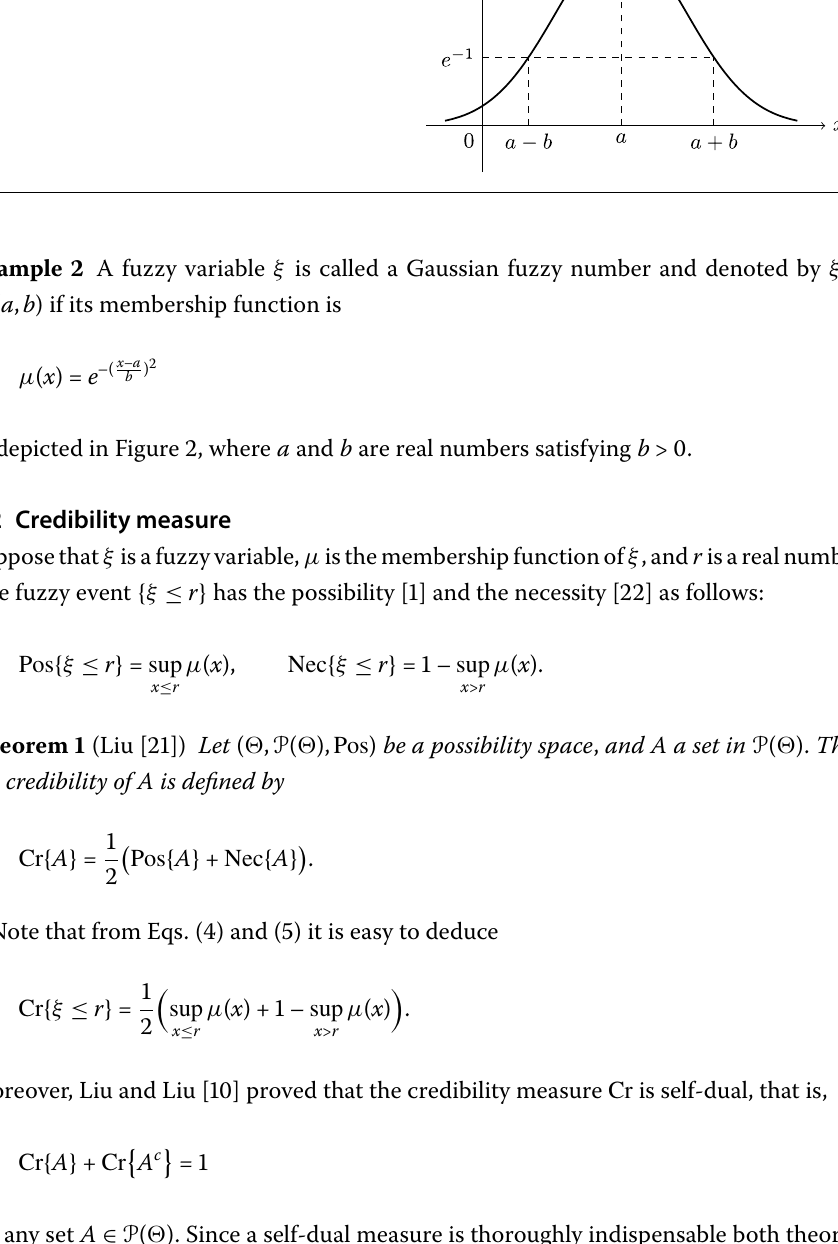
Figure 2 The membership function in Example 2. μ ( x ) is the membership function of a Gaussian fuzzy number ξ ∼ N ( a , b ), and e –1 is